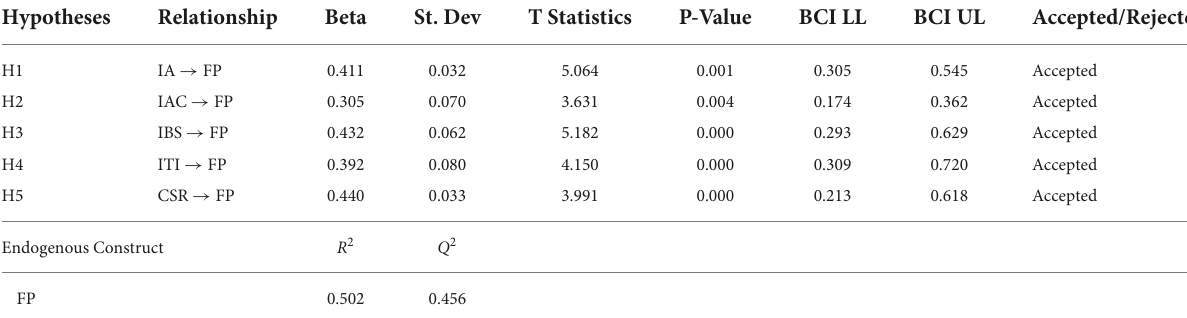
TABLE 3 Hypothesis testing results.